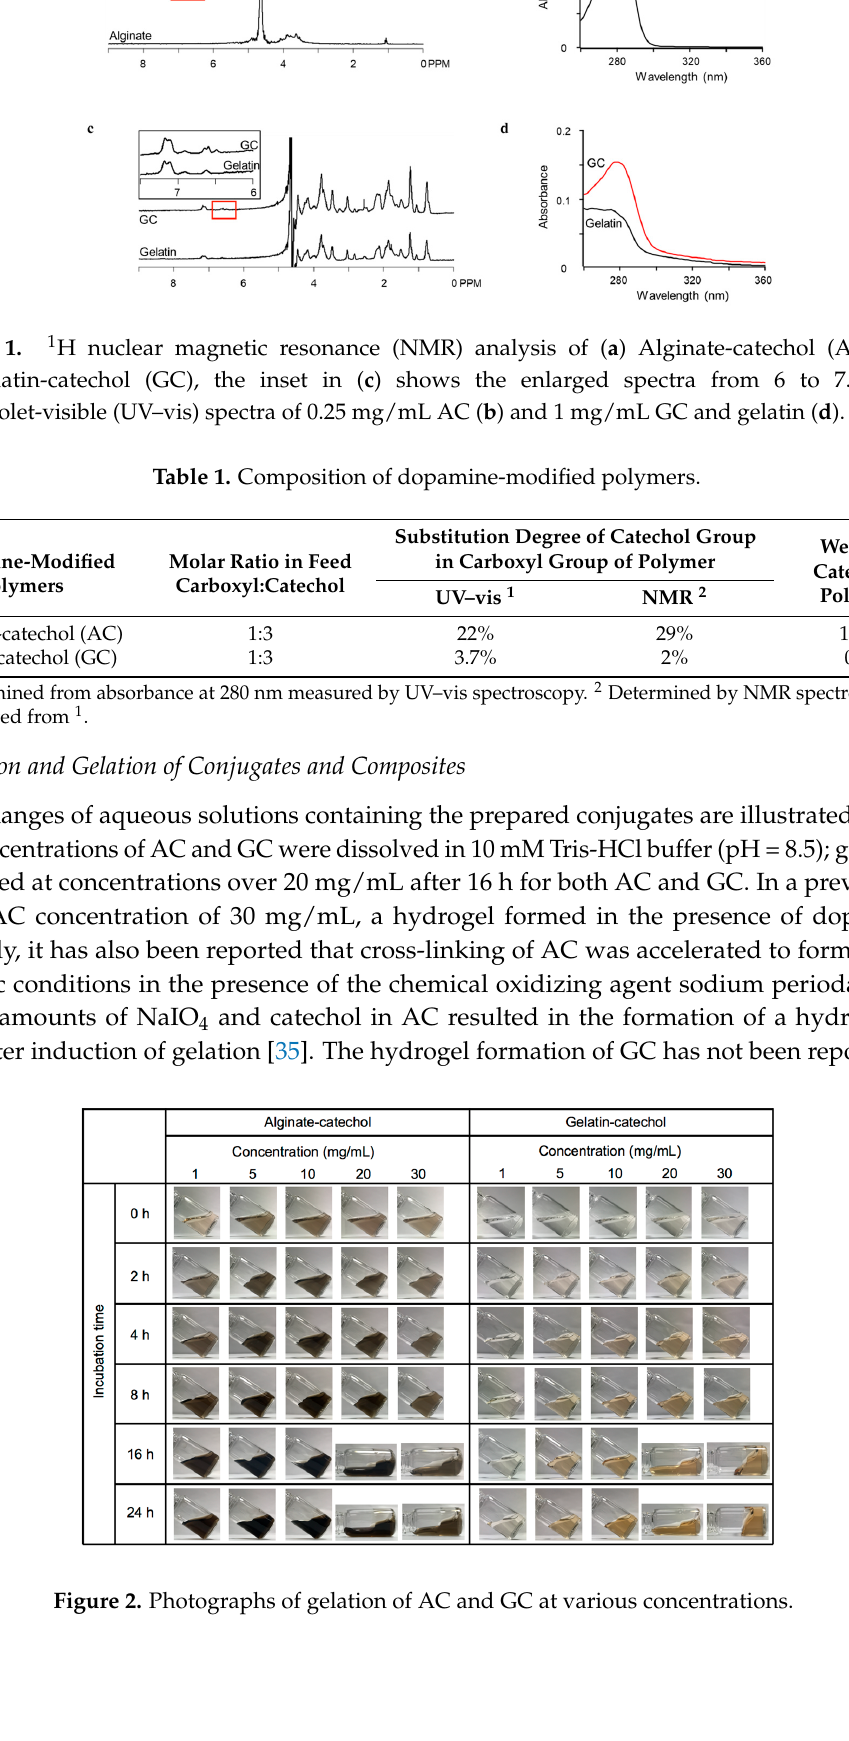
Figure 2. Photographs of gelation of AC and GC at various concentrations.